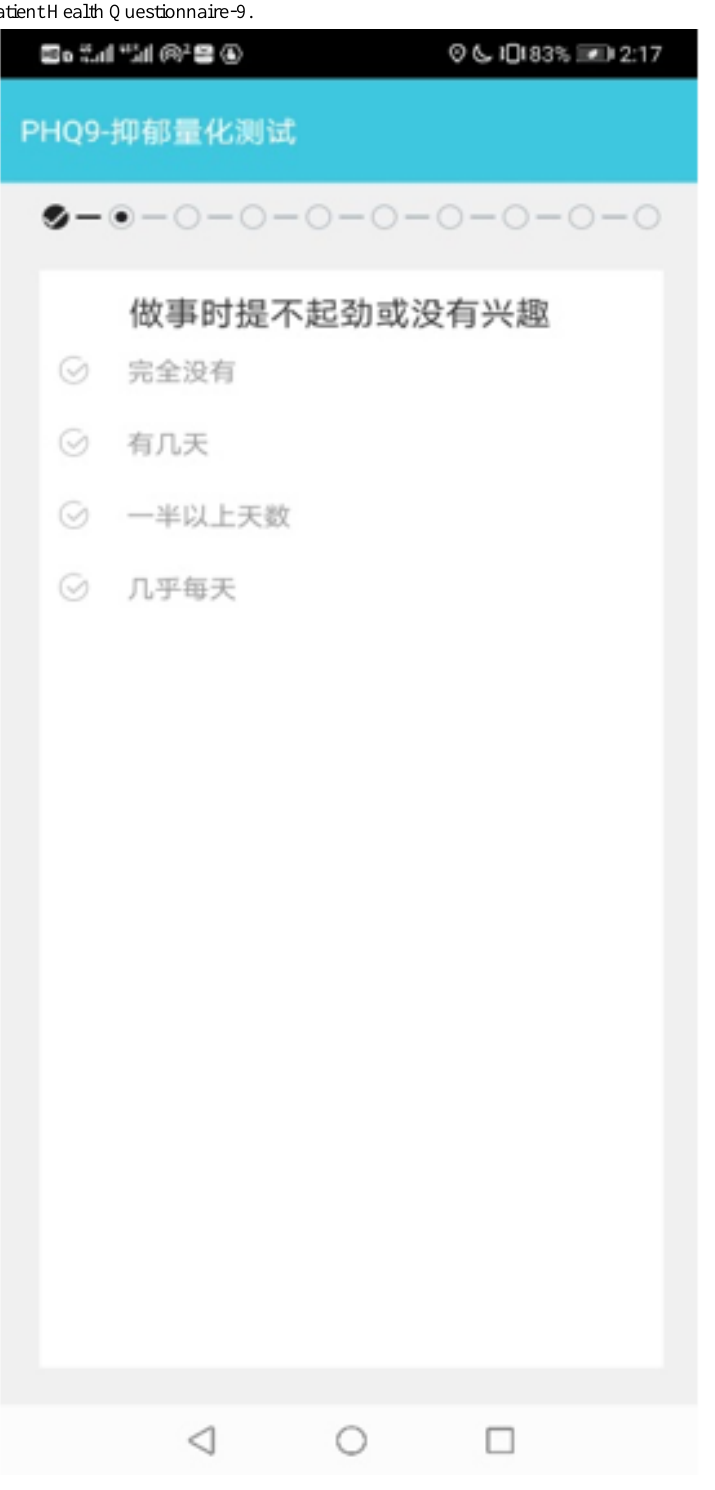
Figure 4. Screenshot of filling Patient Health